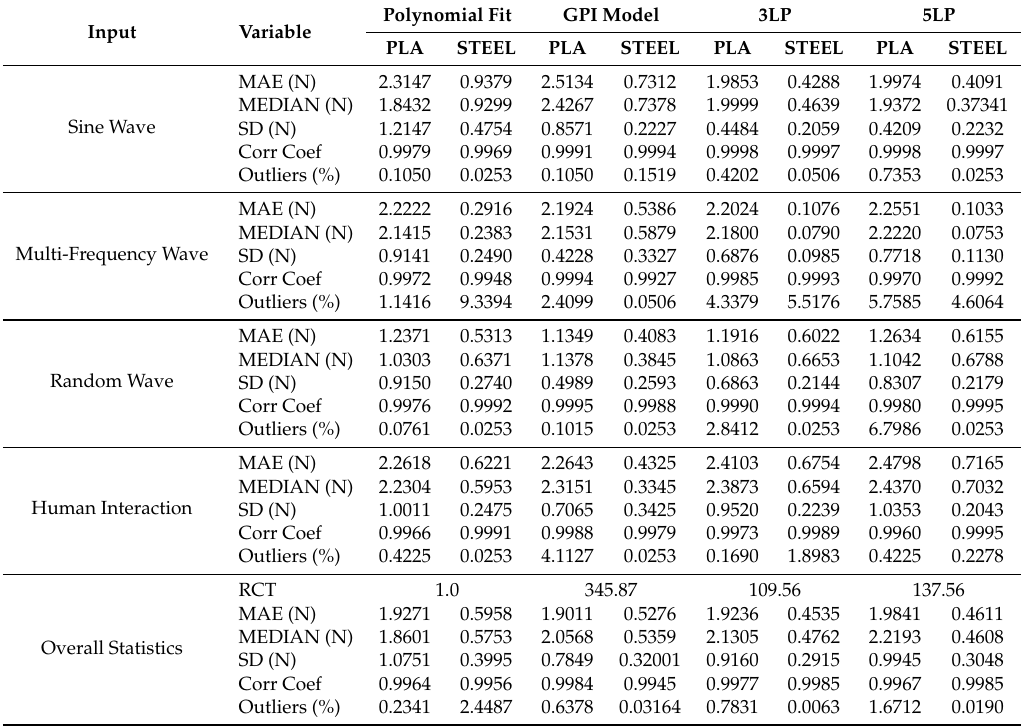
Table 1. This table contains statistical information about the results obtained in the validation experiment. MAE refers to the Mean Absolute Error, MEDIAN to the Median of the absolute error, SD to the Standard Deviation, Corr Coeff to the Cross correlation coefficient, Outliers to the percentage of samples that lie out of the MEDIAN ± 2SD interval, and RCT to the relative computation time with respect to the time required to compute the Polynomial